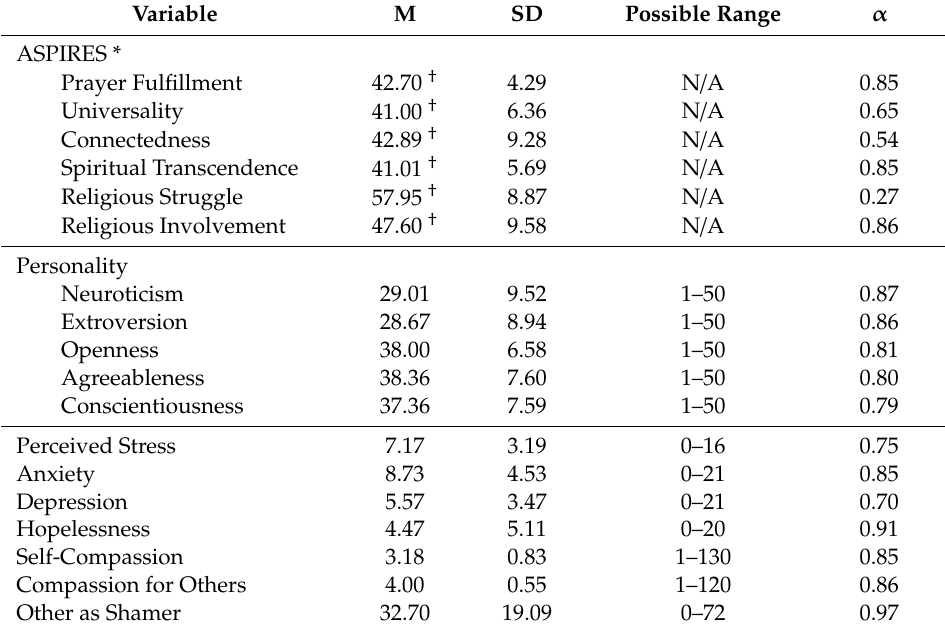
Table 3. Means (M), standard deviations (SD), ranges and alpha reliabilities ( α ) for study